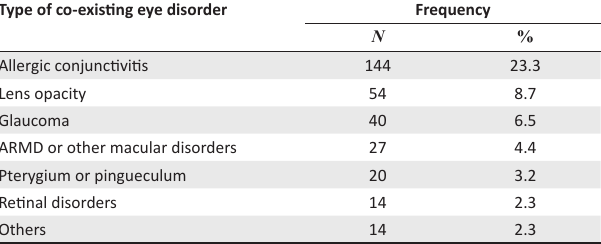
TABLE 3: Co-existing ocular disorders with refractive error in the study population. Type of co-existing eye disorder